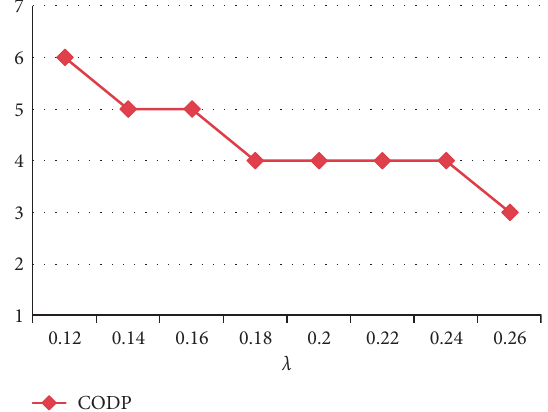
Figure 11: The optimal CODP when λ changes from 0.12 to